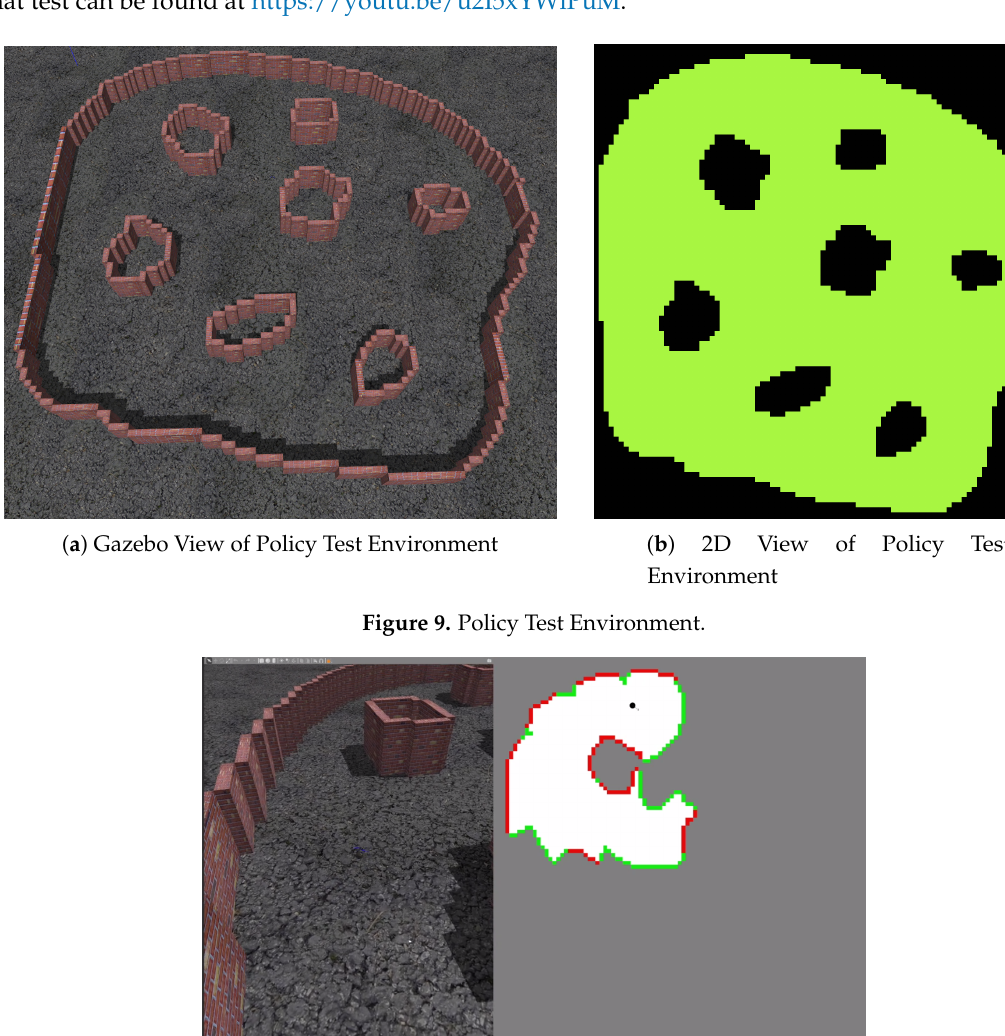
Figure 10. 3DR Solo Policy Test